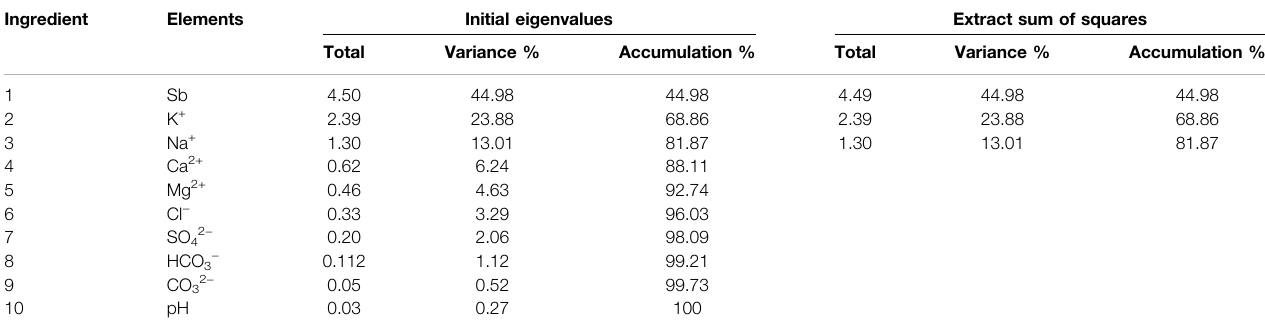
TABLE 3 | Principal component analysis in the study area.